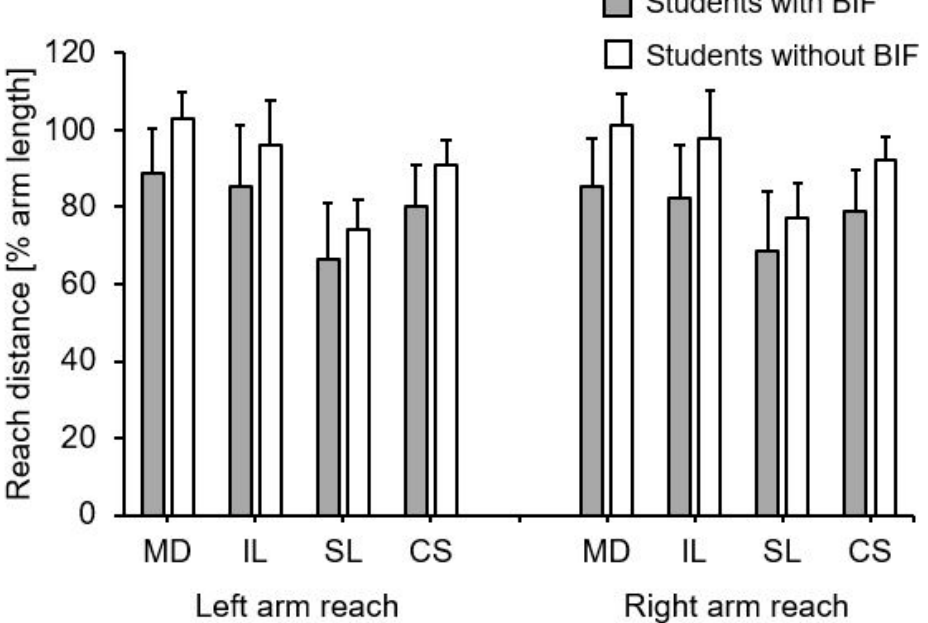
Figure 4. Group mean values and standard deviations for the normalized Upper Quarter Y Balance Test performance by student group. Notes: BIF = borderline intellectual functioning; CS = composite score; IL = inferolateral reach; MD = medial reach; SL = superolateral reach.